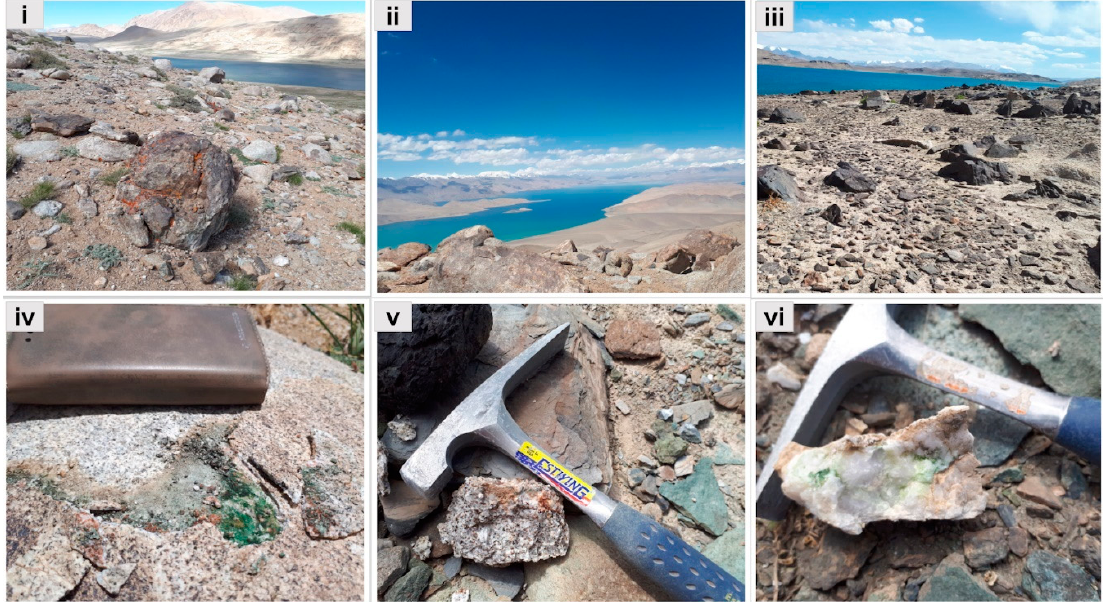
Figure 1. Sampling sites and samples representing the studied groups. ( i ) Sampling site and ( iv ) granite collected from the Lake Khargush, ( ii ) Lake Karakul, and ( v ) sample representing granite from group B, ( iii ) sampling site situated near the Karakul, and ( vi ) sample of quartzites from group C.